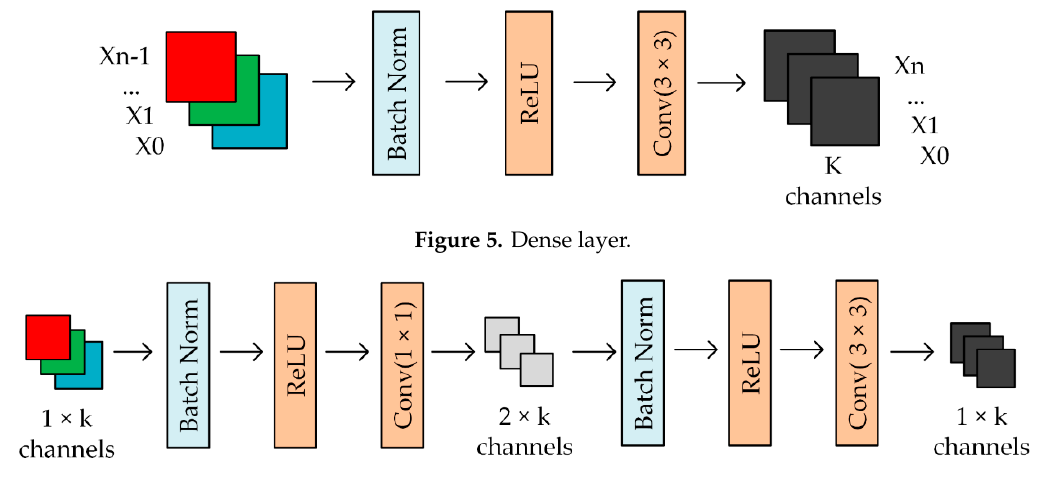
Figure 5. Dense layer.